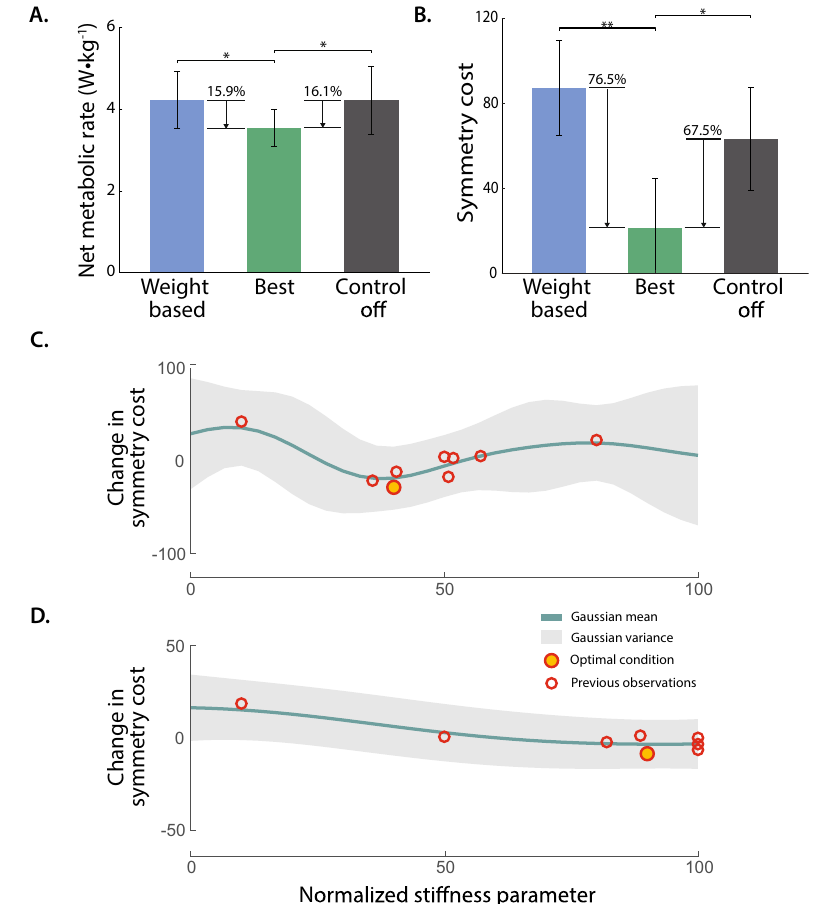
Figure 3. HIL optimization experimental results using the symmetric foot force-time integral (FFTI) percentage. ( A ) Measured metabolic cost of walking, tested in validation trials. Optimized assistance reduced metabolic cost compared to baseline conditions (bars: means; error bars: standard deviations; asterisk: statistical significance (p < 0.05)). ( B ) Symmetry cost during validation trials (double asterisk: statistical significance (p < 0.005)). Optimized assistance presented lower symmetry cost compared to the weight based and control off conditions. ( C–D ) Change in symmetry cost using symmetric FFTI percentage for two representative